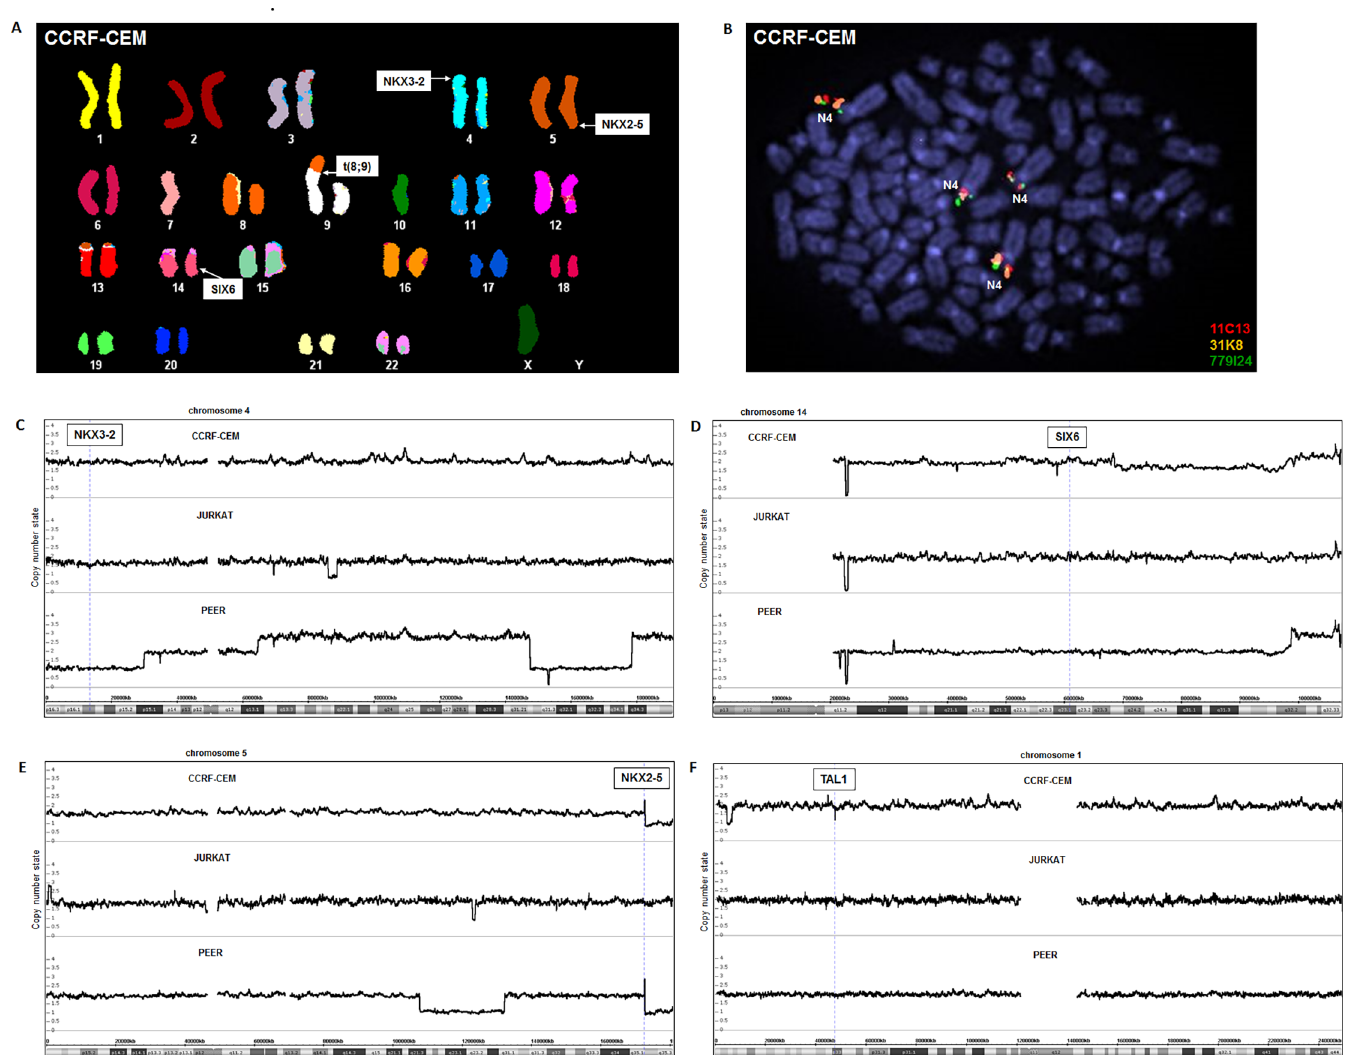
Fig 3. Chromosomal and genomic analyses of NKX3-2. (A) SKY analysis of CCRF-CEM revealed the aberration t(8;9). The loci for NKX3-2, NKX2-5 and SIX6 are indicated. (B) FISH analysis of the NKX3-2 locus in CCRF-CEM demonstrates wild type configurations (N4: normal chromosome 4). Genomic profiling data of T-ALL cell lines CCRF-CEM, JURKAT and PEER for chromosome 4 (C), chromosome 14 (D), chromosome 5 (E), and chromosome 1 (F). The localizations of selected genes including NKX3-2, SIX6, NKX2-5 and TAL1 are